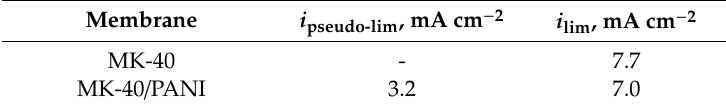
Table 2. The values of limiting current densities for MK-40 and MK-40/PANI membranes in the model solution at 20 °C.